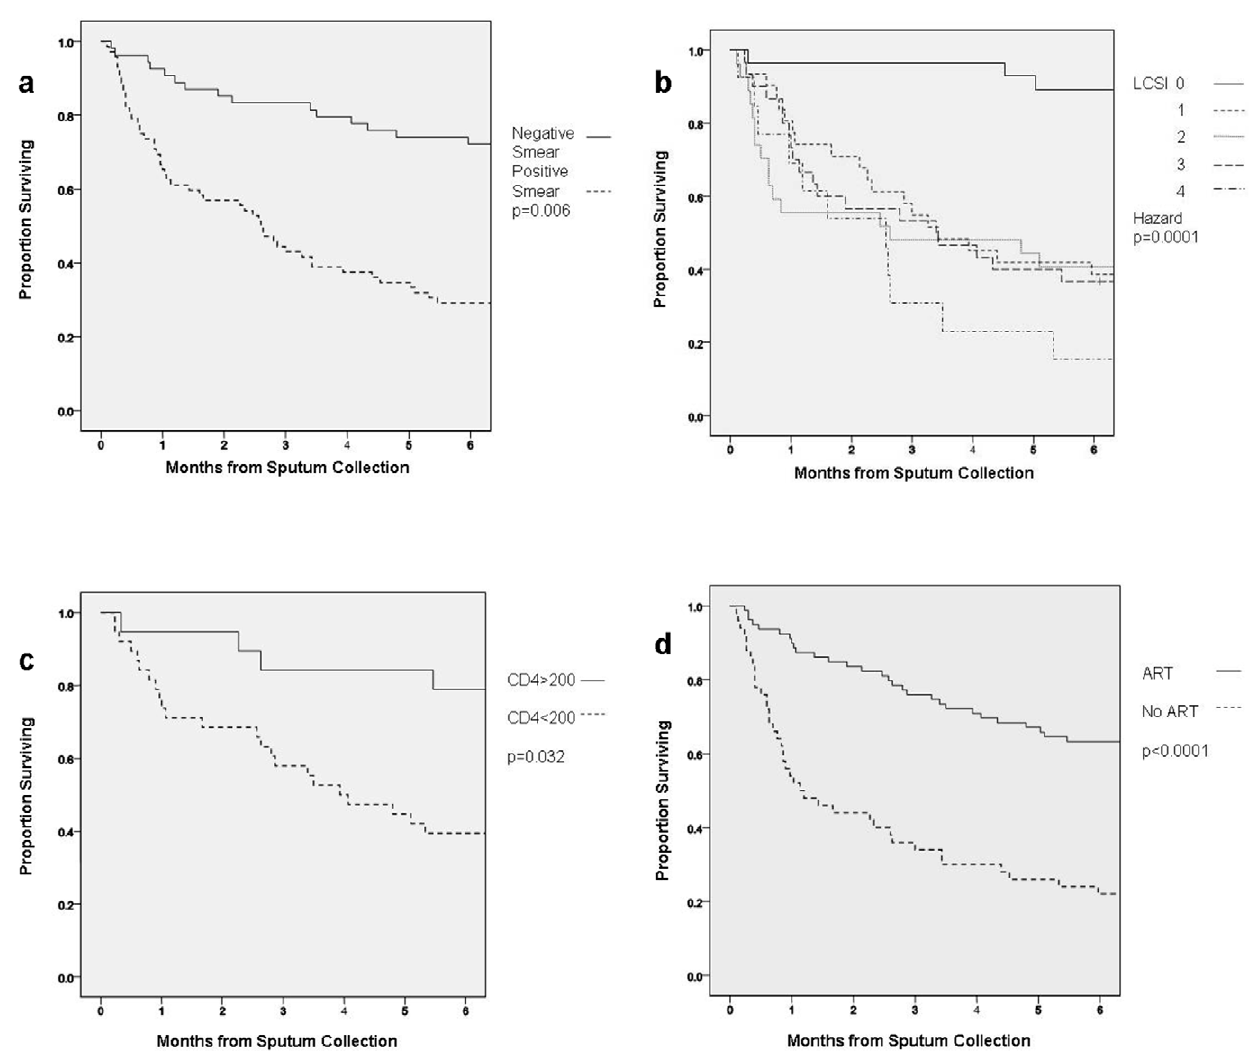
Figure 3. Kaplan-Meier Estimates of XDR-TB Survival in HIV-Infected Patients (Months), n=129. a. Probability of survival according to auramine smear status from time of sputum collection b. Probability of survival according to severity of organ dysfunction at sputum collection c. Probability of survival according to baseline CD4 count at sputum collection d. Probability of survival according to use of ART from the time of sputum collection.